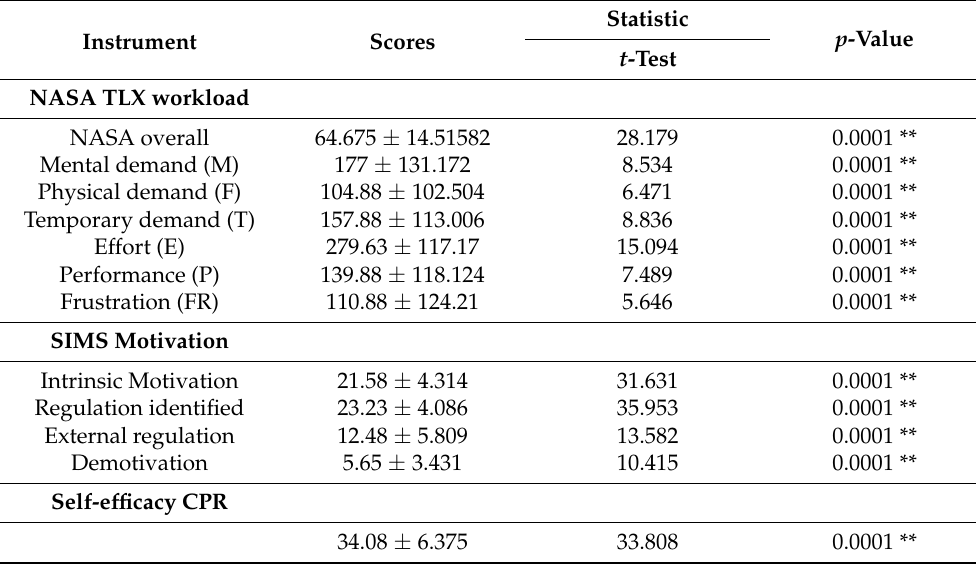
Table 2. Descriptive statistics of self-reported socio-emotional competencies (workload, motivation and self-efficacy) using the NASA TLX workload, the SIMS motivation scale, the self-efficacy CPR scale and their corresponding